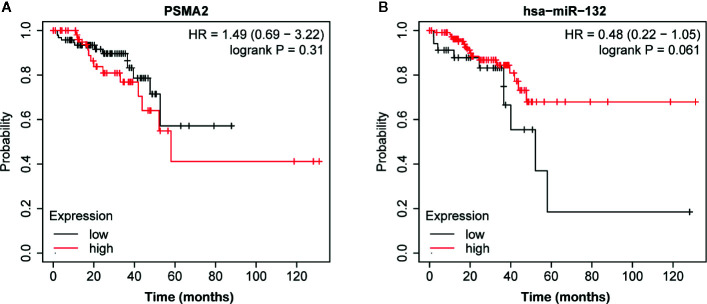
The correlation between miR-132 or PSMA2 levels and overall survival time in CRC. (A) No significant correlation between PSMA2 expression and survival time was observed in CRC. (B) CRC patients with higher expression of MIR-132 displayed longer overall survival time.